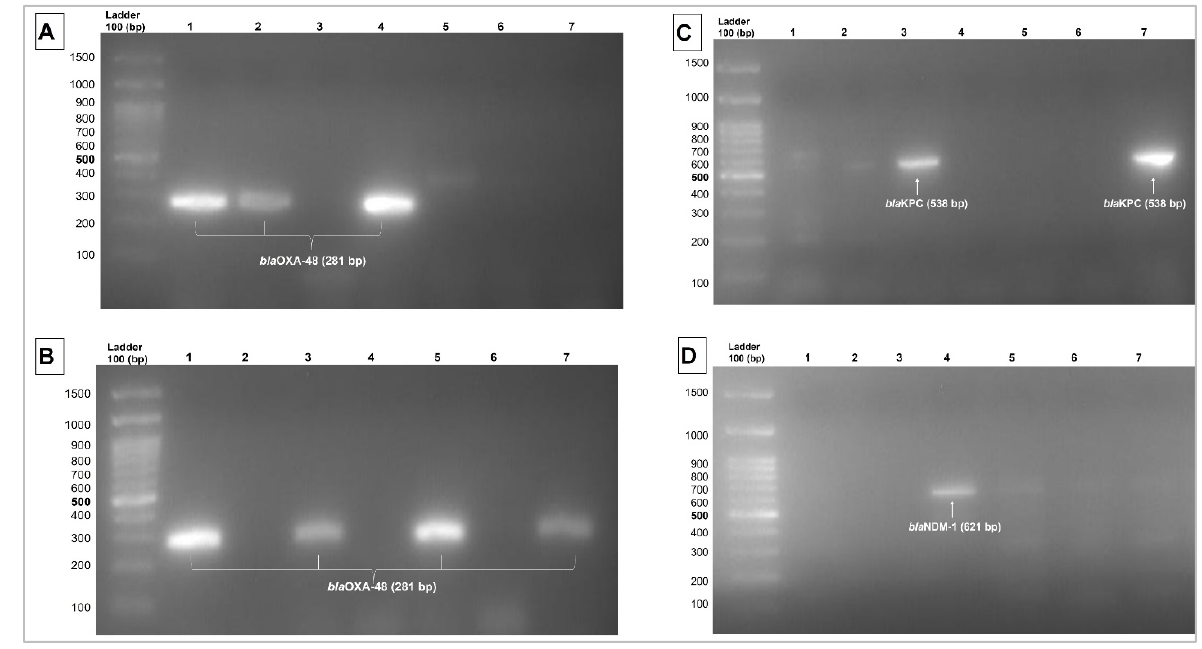
Figure 1. Results of multiplex PCR amplification of genes in MDR Klebsiella pneumoniae : ( A ) Lane 1,